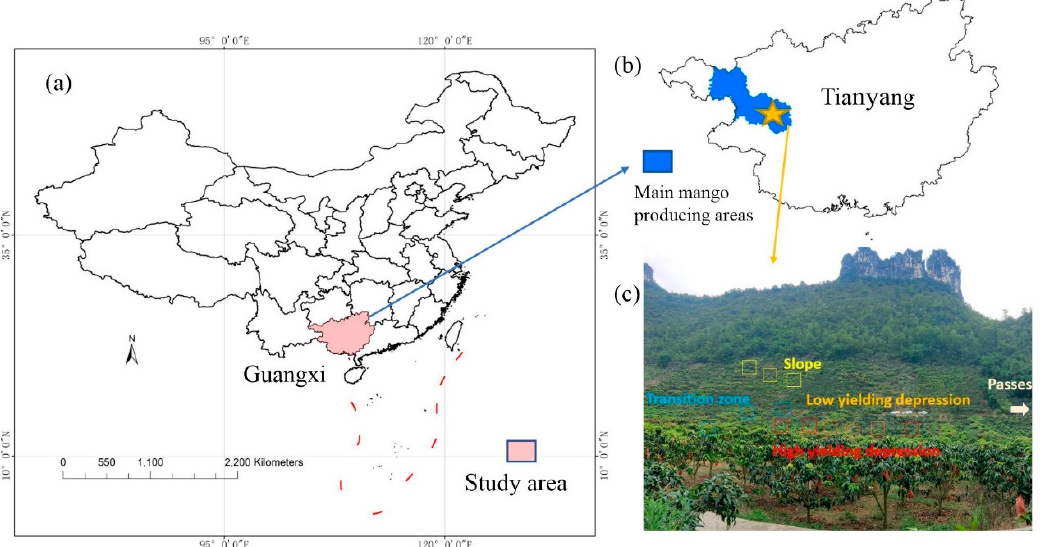
Figure 1. Location of the study area and growth of mangoes. ( a ) Geographical location of the study area, ( b ) main mango producing areas and the exact location of the study area in Baise City, ( c ) live picture of peak-cluster depression and the allocation of sampling.